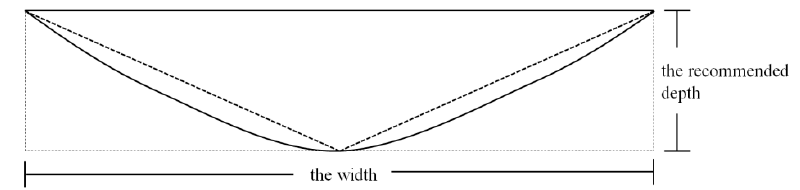
Figure 2. The typical cross section of the submergible green space.